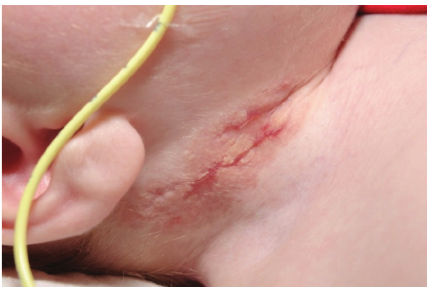
Figure 1: 24/12/14: deep violaceous ulcerated area with an under- mined border on the right side of neck corresponding to site of arterial line insertion.